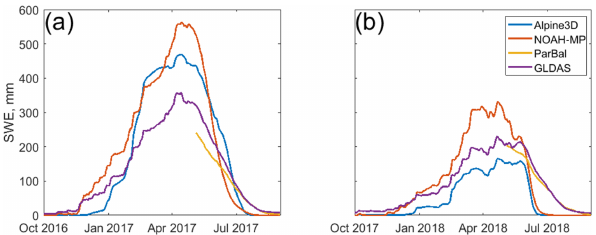
Figure 6. Time series of mean SWE for four snow models across the study area (13 pixels × 13 pixels, each 25km 2 ) shown in Fig. 1 for 2017 (a) and 2018 (b) . The reconstructed SWE from ParBal (yellow) goes back to 4 May, the median peak SWE date for both years, since reconstruction is only valid during the ablation season.